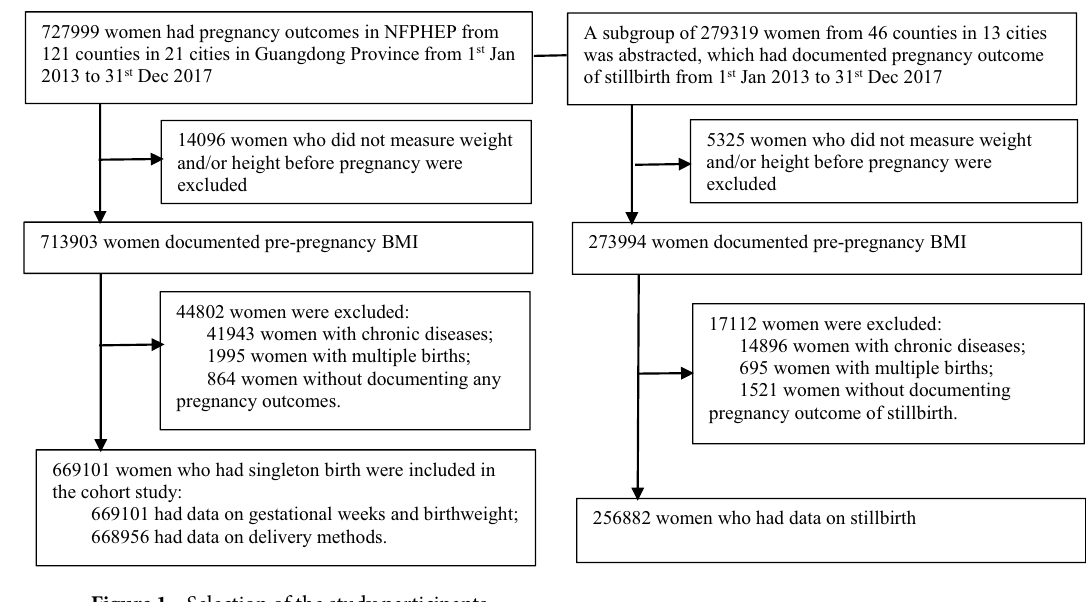
Figure 1. Selection of the study